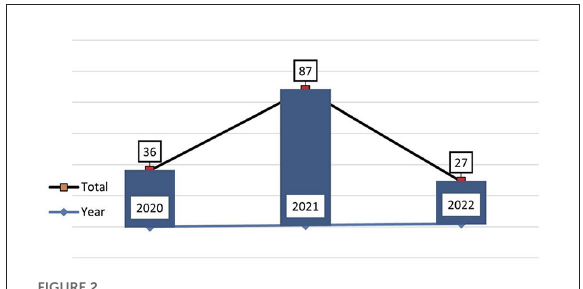
FIGURE2 Publication trend of burnout health worker.